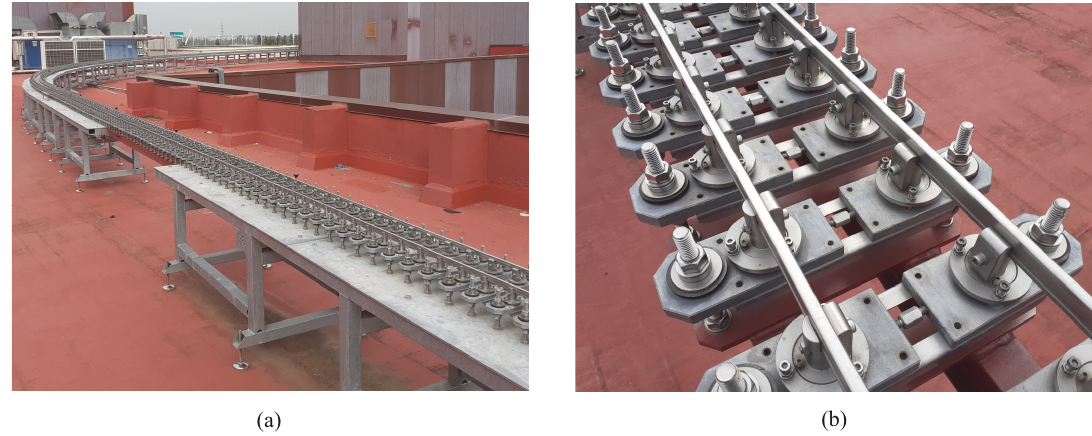
Figure 4. Scaled track assembly ( a ) and mechanical sleepers ( b